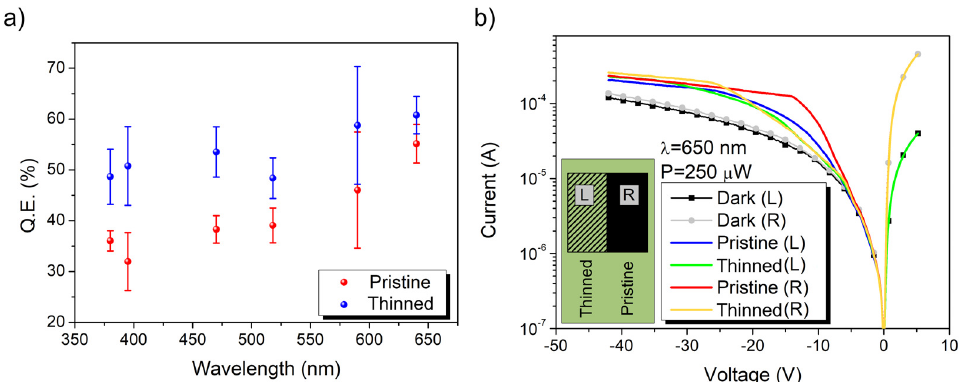
Figure 5. ( a ) Average QE of the device at the plateau and associated standard deviation (error bars) as a function of the wavelength. Red dots represent the values of the QE obtained on the pristine portion of the film, while the blue dots represent the values from the thinned portion. ( b ) Comparison of the I-V curves acquired using the left or right pads as electric contacts (indicated by the letters L and R), in the dark and under the light of a 650 nm laser at 250 µW (with light spot focused on the thinned or pristine film).